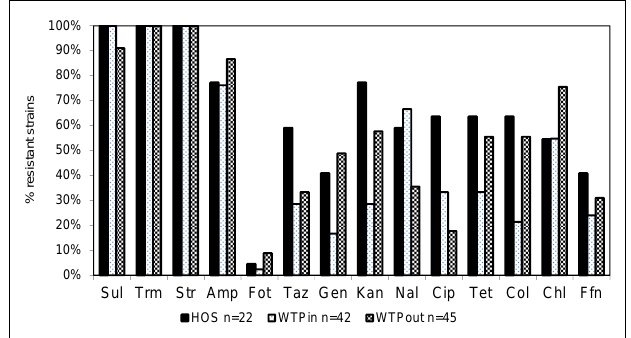
FIGURE 5 | Percentage of bacterial isolates from HOS,WTPin, and WTPout that were classified as resistant to the listed antibiotics.